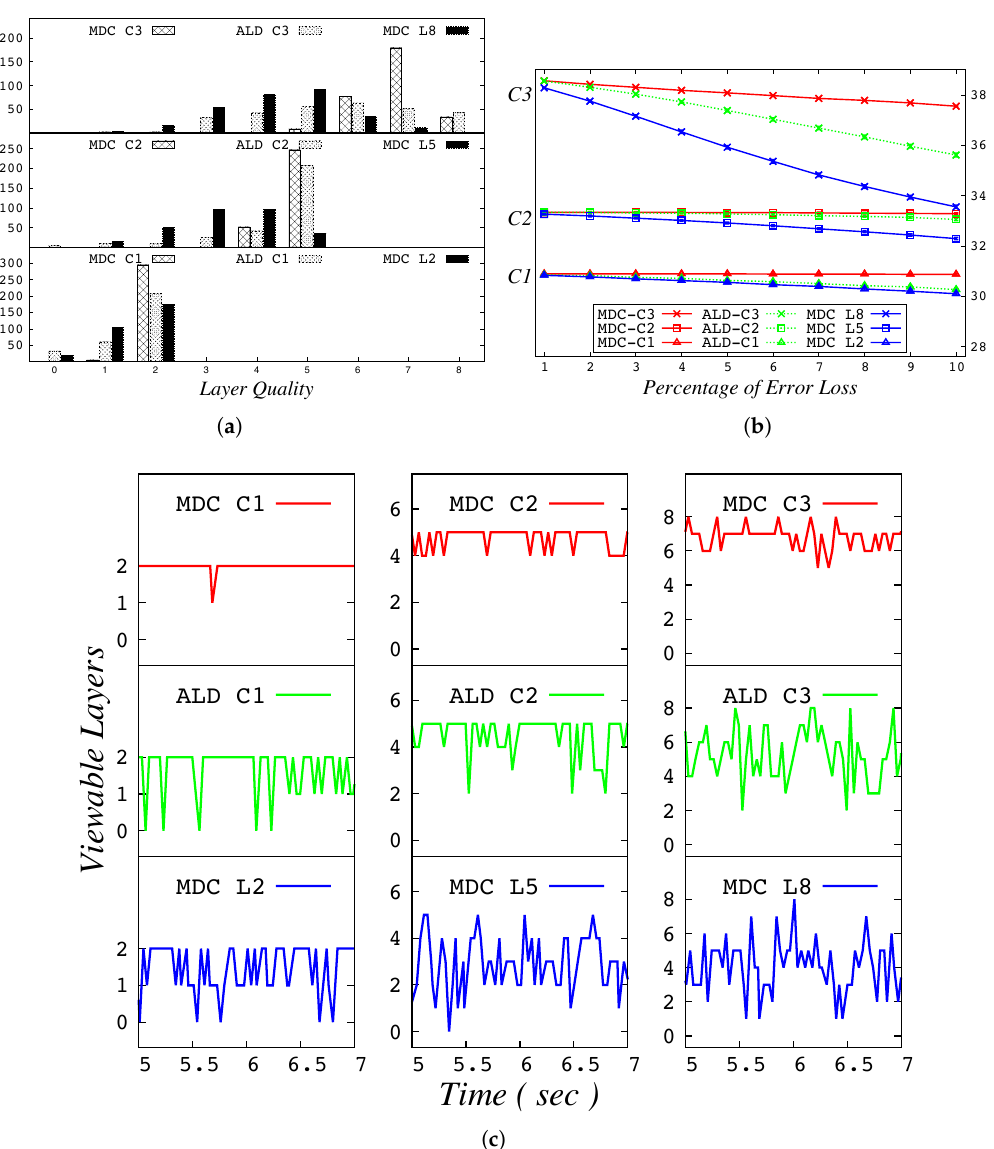
Figure 15. Performance evaluation of considered schemes using ROP for SCs. ( a ) video quality for different schemes at 10% loss; ( b ) average Y-PSNR values for different schemes with 95% confidence interval results; ( c ) 2 s sample of viewable quality transitions for MDC (layers L2, L5 and L8) and for each of the classes of ALD-SC and MDC-SC (maximum quality per class equating to layers 2, 5 and